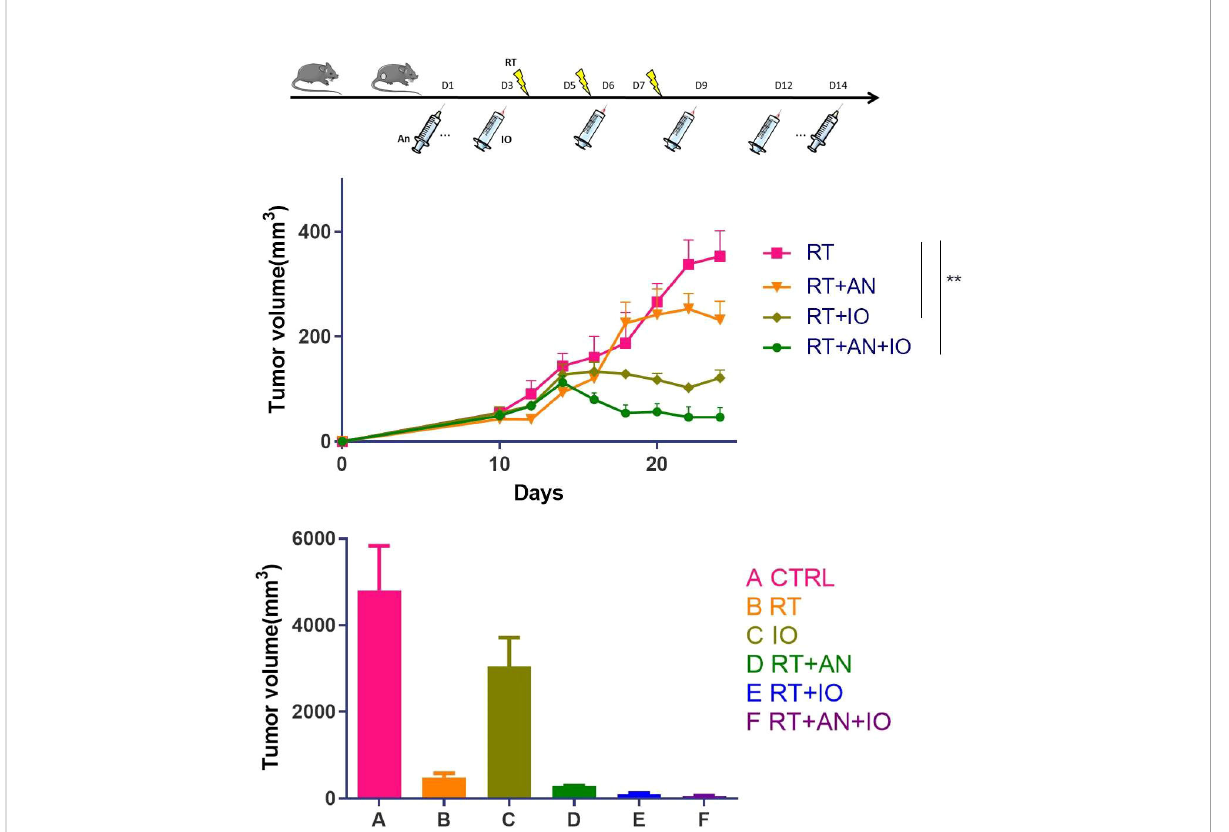
FIGURE 2 Radiotherapy combined with anti-PD-L1 and anlotinib showed the most remarkable antitumor effect in murine lung cancer. CTRL, control; RT, radiotherapy; IO, immunotherapy; AN, anlotinib. Adapted from our published article (ref. 45), copyright 2022 Meng Yuan et al., with permission from Hindawi. ∗∗ represents p values <